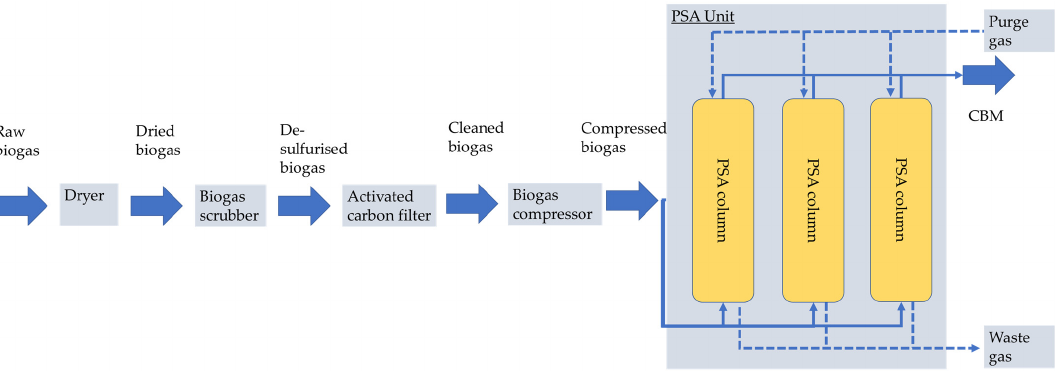
Figure 12. CA biogas-to-biomethane upgrading pathway. In addition to CA technology, a scrubber and an activated carbon filter have been added to remove H 2 S and traces of volatile organic com- pounds (VOCs). The amine solvent is recycled into the absorber as it: a. utilises the heat from the heat exchanger, and b. CO 2 is removed by the stripper. A compressor is preliminarily added for compressed biomethane.